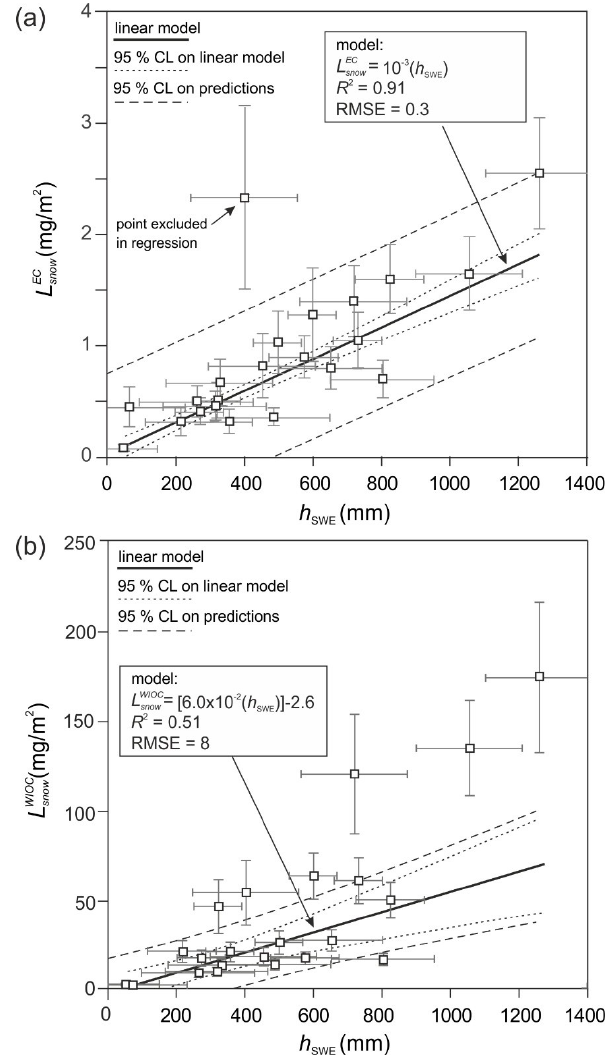
Figure 6. Scatterplot of (a) L EC snow and (b) L WIOC snow against h SWE based on measurements from Svalbard glacier snowpits from the April 2016 survey. The vertical error bars are ± 1 σ and take into account uncertainties in h SWE , C EC snow , and C WIOC snow . The horizontal error bars ( ± 1 σ ) are based on the RMSE of the values of h SWE predicted by the snow model, relative to field observations (Table 2 in van Pelt et al., 2019). Weighted linear regression models fitted to the data are shown with 95% confidence bounds.